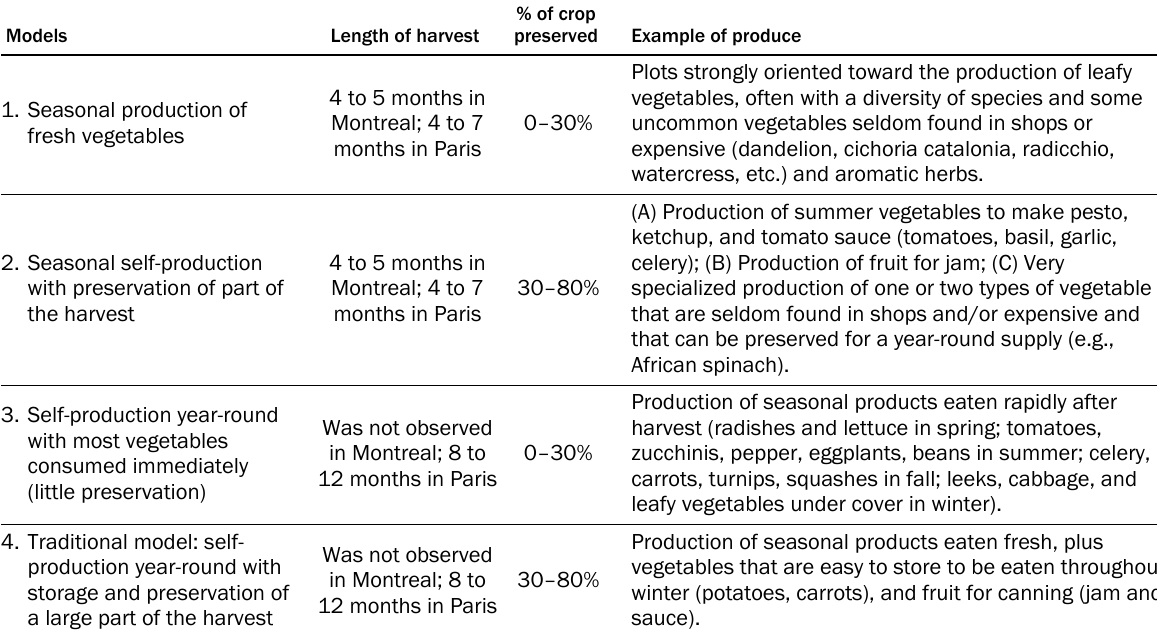
Table 2. Four Models Regarding the Use of Garden Produce Models